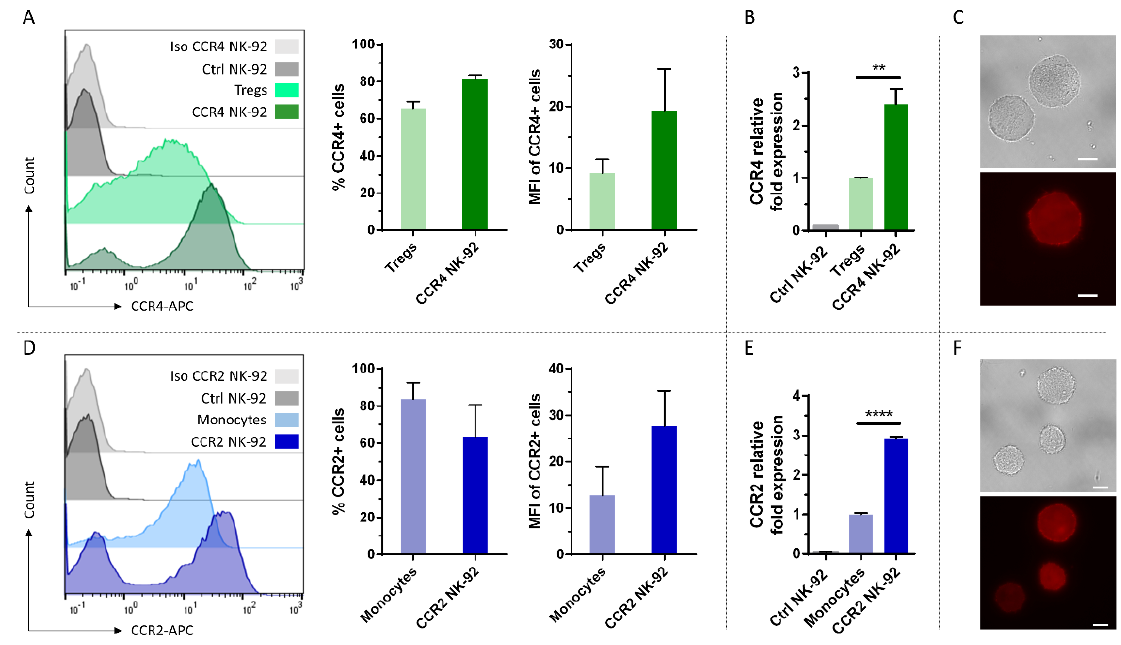
Figure 1. Efficient overexpression of CCR4 and CCR2B on NK-92 cells. ( A , D ) CCR4 or CCR2B ex- pression was analyzed by flow cytometry on NK-92 cells transduced with CCR4- or CCR2B-encoding lentiviral particles and selected for 14 days using 2 µg/mL puromycin. T regs and monocytes that naturally express CCR4 and CCR2, respectively, were used for comparison. Histogram overlay shows the intensity of the APC signal of the CCR4/CCR2-specific antibody. Histogram shows one representative out of n = 3 independent experiments; bar chart shows CCR4-/CCR2-positive fractions and their MFIs. Mean values with SD are shown from n = 3 independent experiments. Ctrl NK-92: Untransduced NK-92 cells stained with CCR4 or CCR2 antibodies. ( B , E ) qPCR analysis of CCR4 or CCR2B transduced NK-92 cells versus T regs or monocytes, respectively. Ctrl NK-92: Untrans- duced NK-92 cells. Mean values with SD are shown from n = 3 independent experiments with three technical replicates each ( C , F ) Immunofluorescence microscopy of CCR4/CCR2B transduced NK-92 cells. Upper panel: bright field, lower panel: fluorescence staining of the respective antibodies directed against CCR4 and CCR2 chemokine receptors. Scalebar represents 10 µm. **: p ≤ 0.01. ****: p ≤ 0.0001.